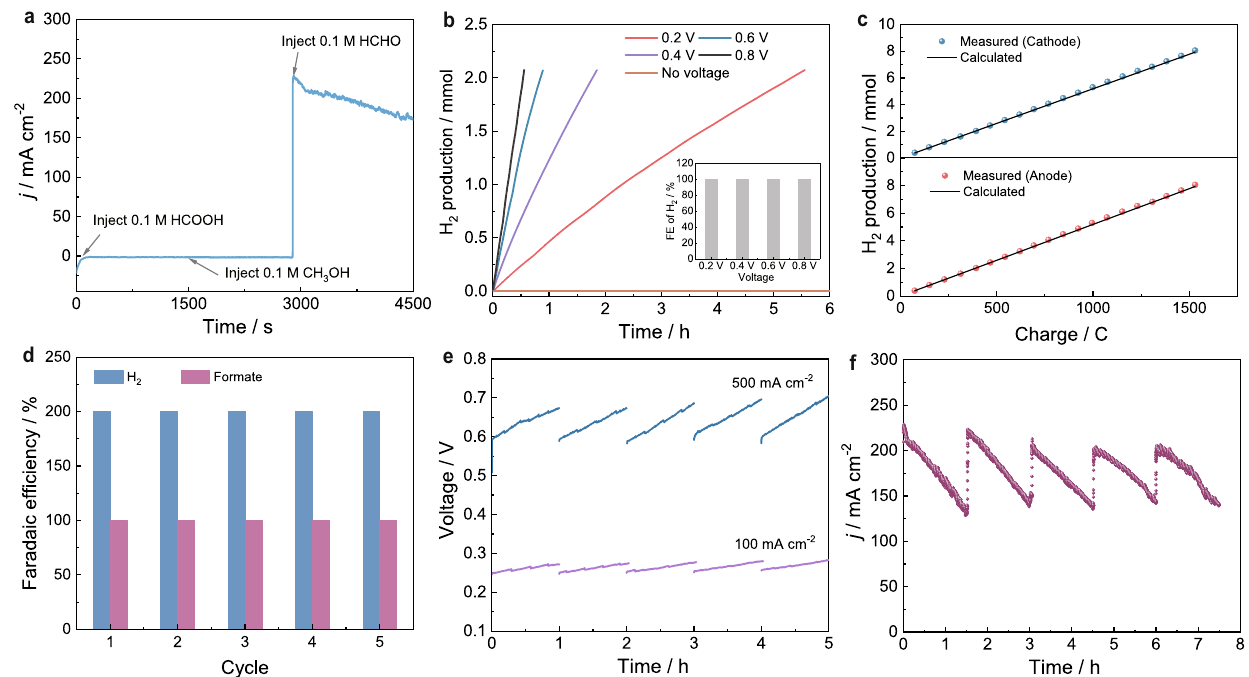
Fig. 4 | Dual hydrogen production of FOR/HER system. The electrolysis experi- ments were conductedin a two-electrode electrolyzer using Cu 3 Ag 7 /CF anode and Ni 3 N/Ni/NF cathode. a Chronoamperometric curve collected at a cell voltage of 0.6V in 1.0M KOH with the continuous addition of 0.1M HCOOH, 0.1M CH 3 OH, and 0.1M HCHO in the anode chamber. b Comparison of the experimentally measured amount of H 2 from the anode chamber with different voltage inputs. Inset shows the Faradaic ef fi ciency of H 2 production. c Comparison of the experi- mentally measured H 2 amounts with the theoretical H 2 amounts calculated from